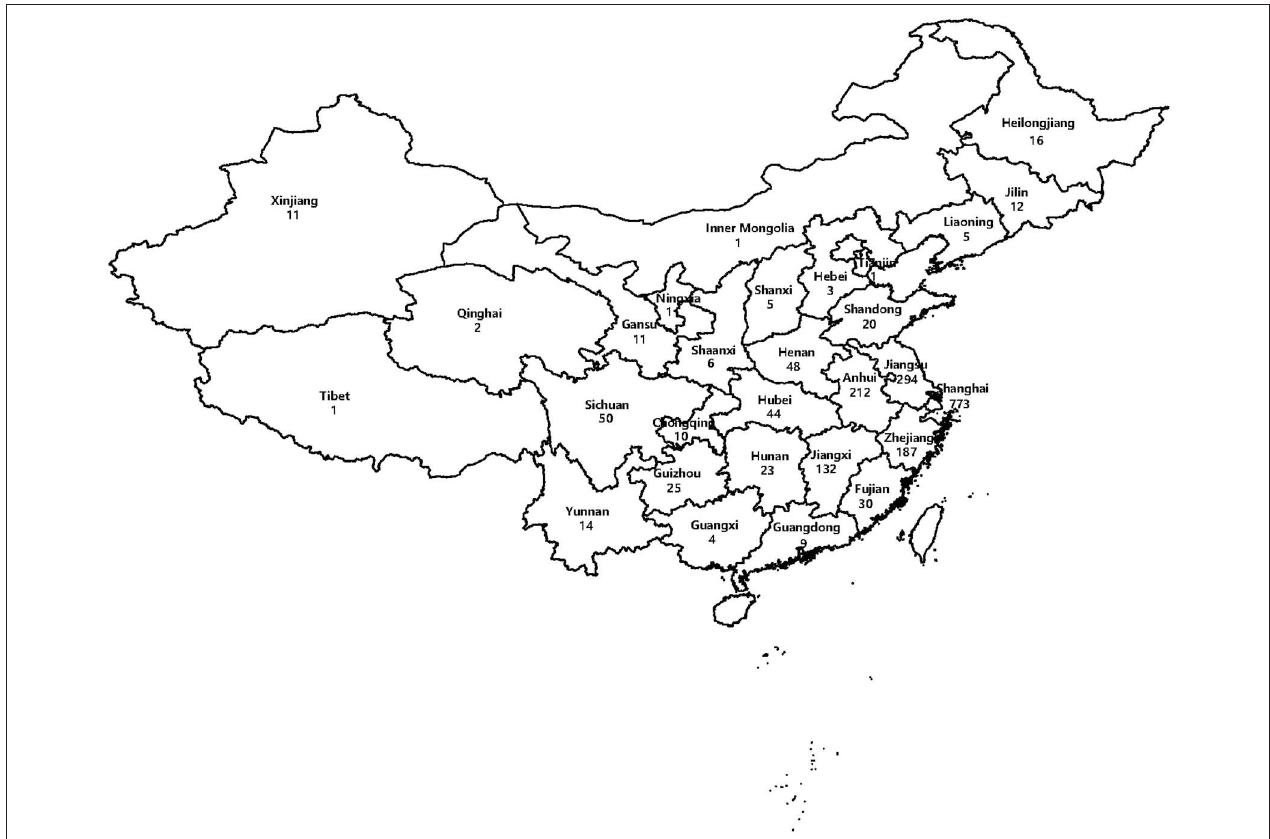
FIGURE 1 | Map of China showing the distribution of 1,950 isolates included in this study (the numbers indicate the absolute number of isolates every region).